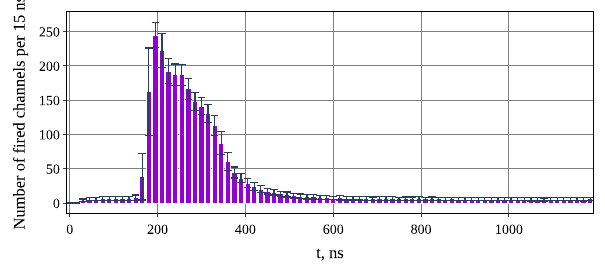
Fig. 7 Average PDF for FHT distribution with deposited energy E dep = 2 . 022 MeV and R = 16 m. Error bars represent the standard deviation in each corresponding bin